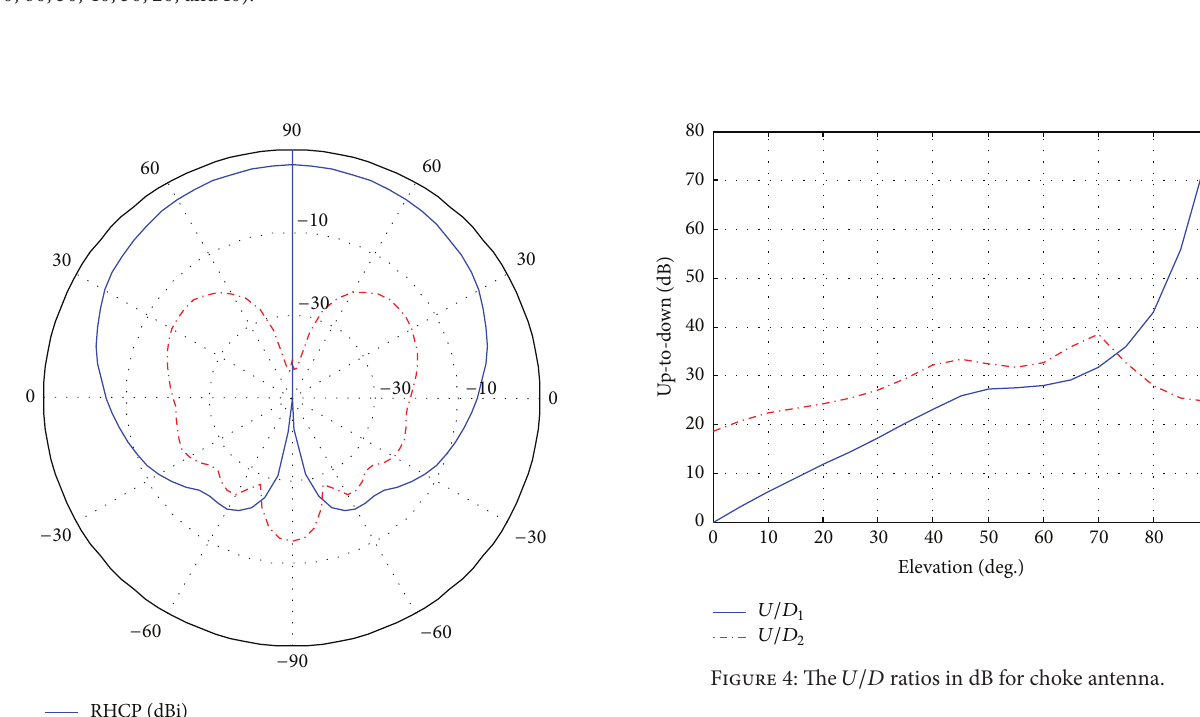
Figure 2: Effect of the multipath around wet ground on the carrier phase against 𝑈/𝐷 1 and 𝑈/𝐷 2 ratios for different elevation angles (80, 70, 60, 50, 40, 30, 20, and 10).